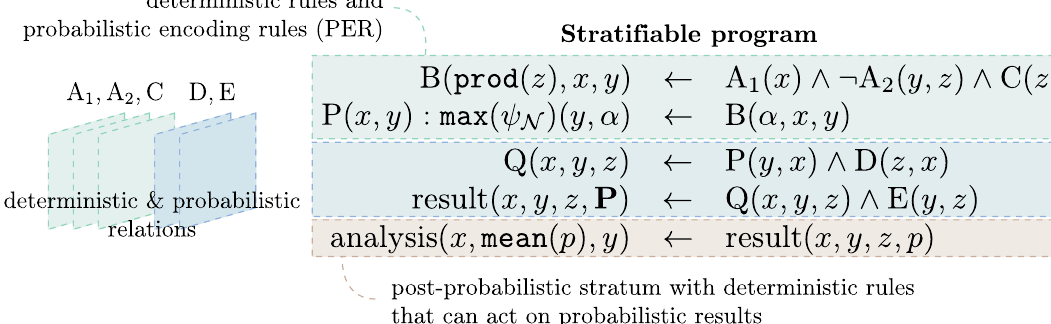
Figure 10. Stratification in NeuroLang. The program’s input contains both deterministic ( A 1 , A 2 , and C ), and probabilistic ( D and E )